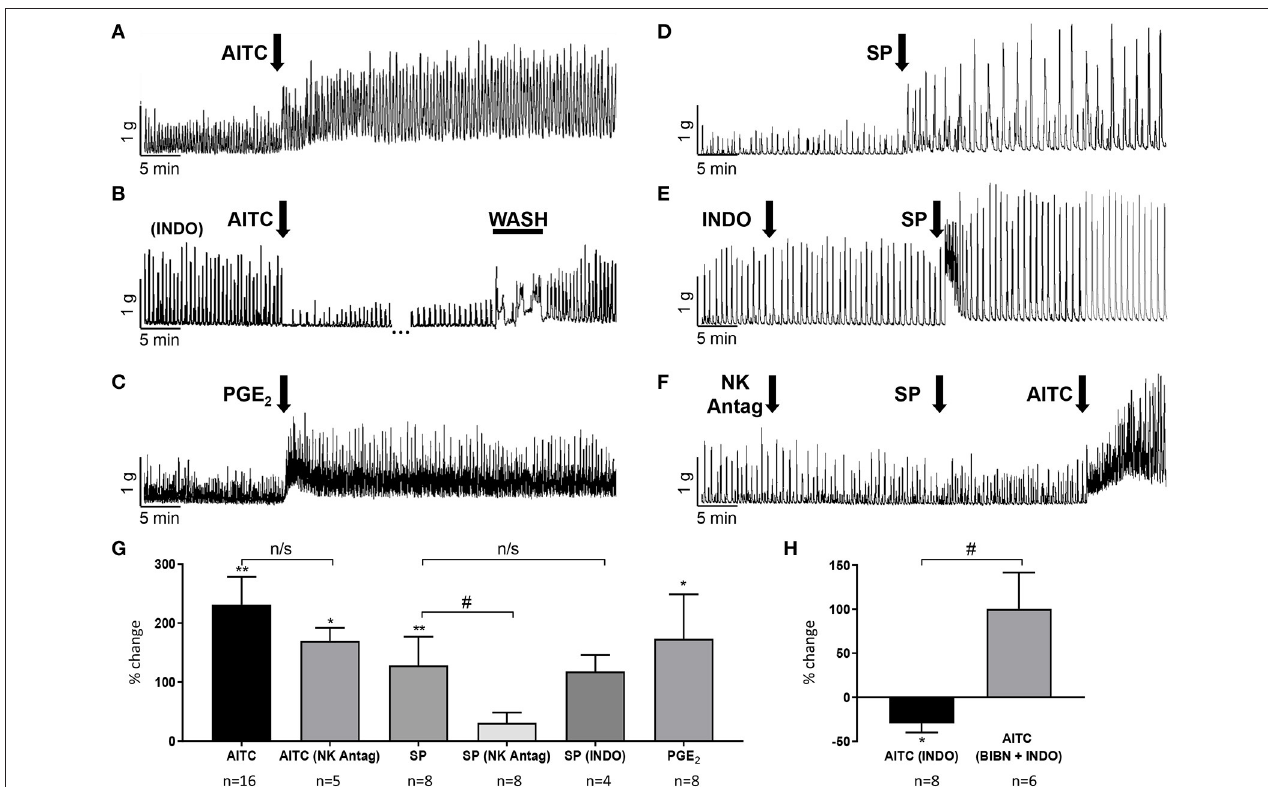
FIGURE 5 | AITC (100 µ M) enhancement of SBCs is mediated by the release of prostaglandins (PG) and not by the release of substance P (SP). (A) AITC enhances SBCs and this effect is reversed to inhibition by pretreatment with indomethacin (INDO, 500nM) (B) which is in turn reversed by a wash (gap in record represents 24min). (C) Prostaglandin E2 (PGE 2 , 500nM) mimicks the excitatory effect of AITC. (D) SP (1 µ M) enhances SBCs; however, this effect is not blocked by INDO (E) but is blocked by a cocktail of neurokinin receptor 1, 2, and 3 antagonists (1 µ M each) which does not block the excitatory effect of AITC (F) . (G) Effects of agonists and antagonists shown in (A–F) are summarized as % change in SBC AUC compared to basal activity, data were obtained from single experiments with either a pristine agonist or an antagonist followed by an agonist (H) . After indomethacin (INDO) treatment AITC reduces SBC and this effect is reversed by BIBN as shown in Figure 4E . Statistics were performed on raw numbers: (G,H) , 2-tailed t -test, * P < 0.05 and ** P < 0.001, and a two-way ANOVA with Bonferroni multiple comparisons post-hoc tests were performed to compare the antagonist effects (brackets), # P < 0.05; n , number of